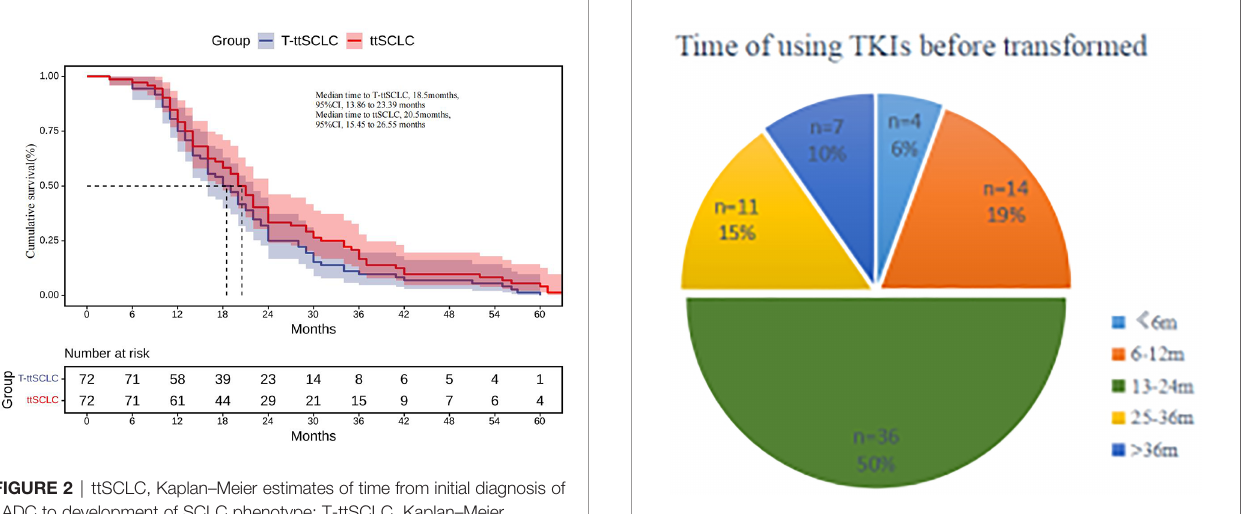
FIGURE 3 | A segmented time scale diagram from the beginning of TKIs using the occurrence of pathological transformation. TKIs, Tyrosine kinase inhibitors; n, number; m,